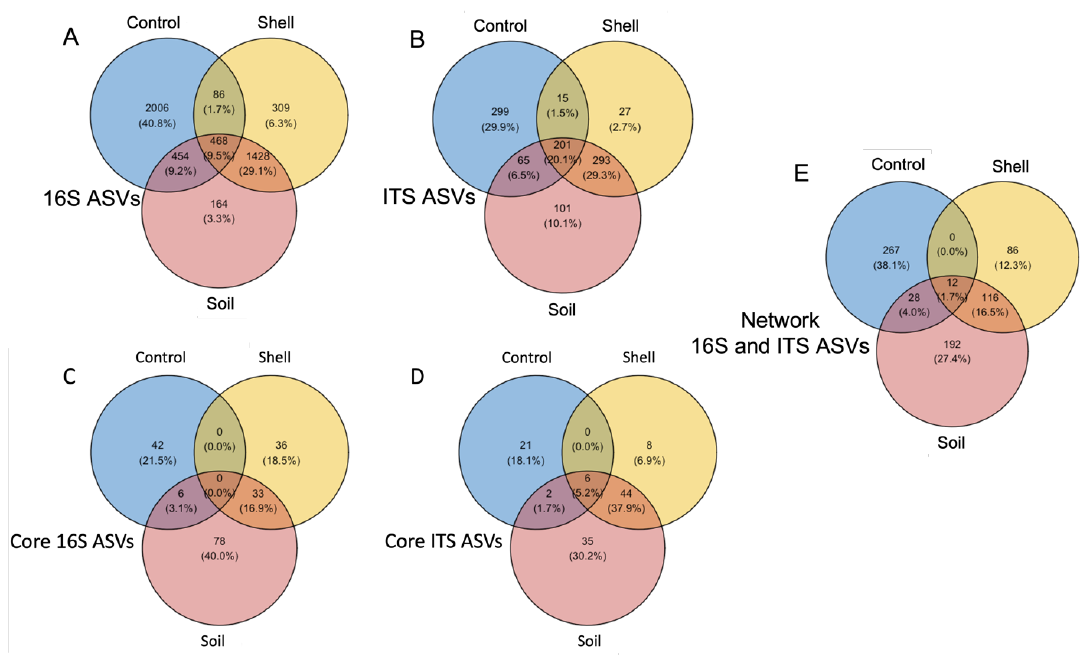
Figure 3. Bacterial and fungal taxa that were differentially represented between Shell, Soil, and Control microbiomes. Based on ALDEx2 Benjamini – Hochberg-corrected p -value of Kruskal – Wal- (Figure 4A,B). lace test.